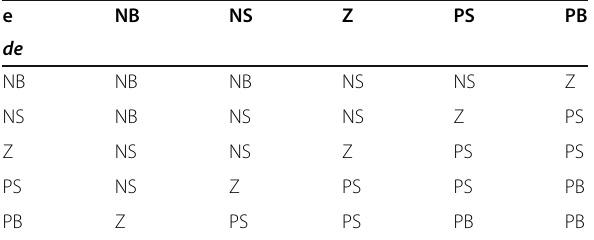
Table 7 Fuzzy rule base for